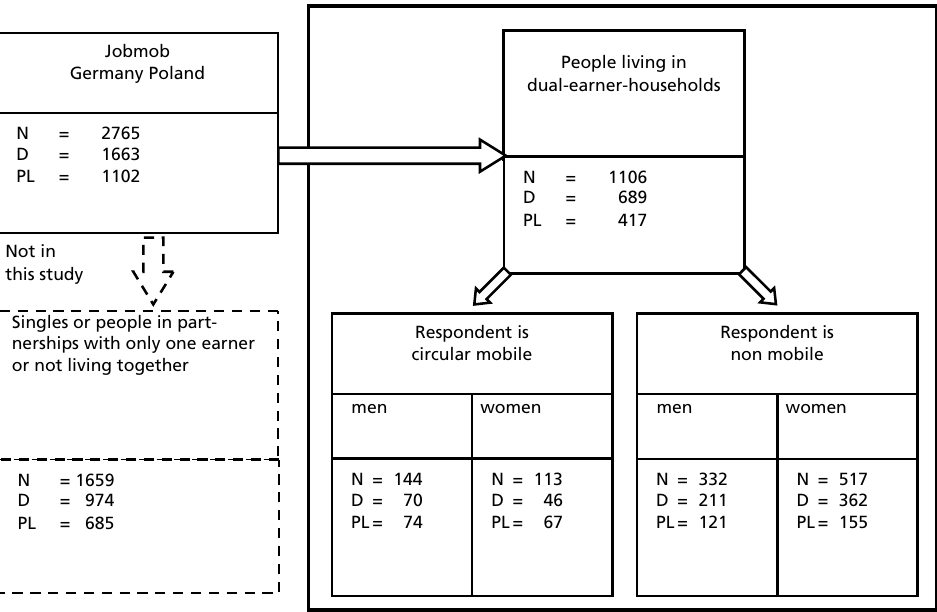
Figure 1: Sample